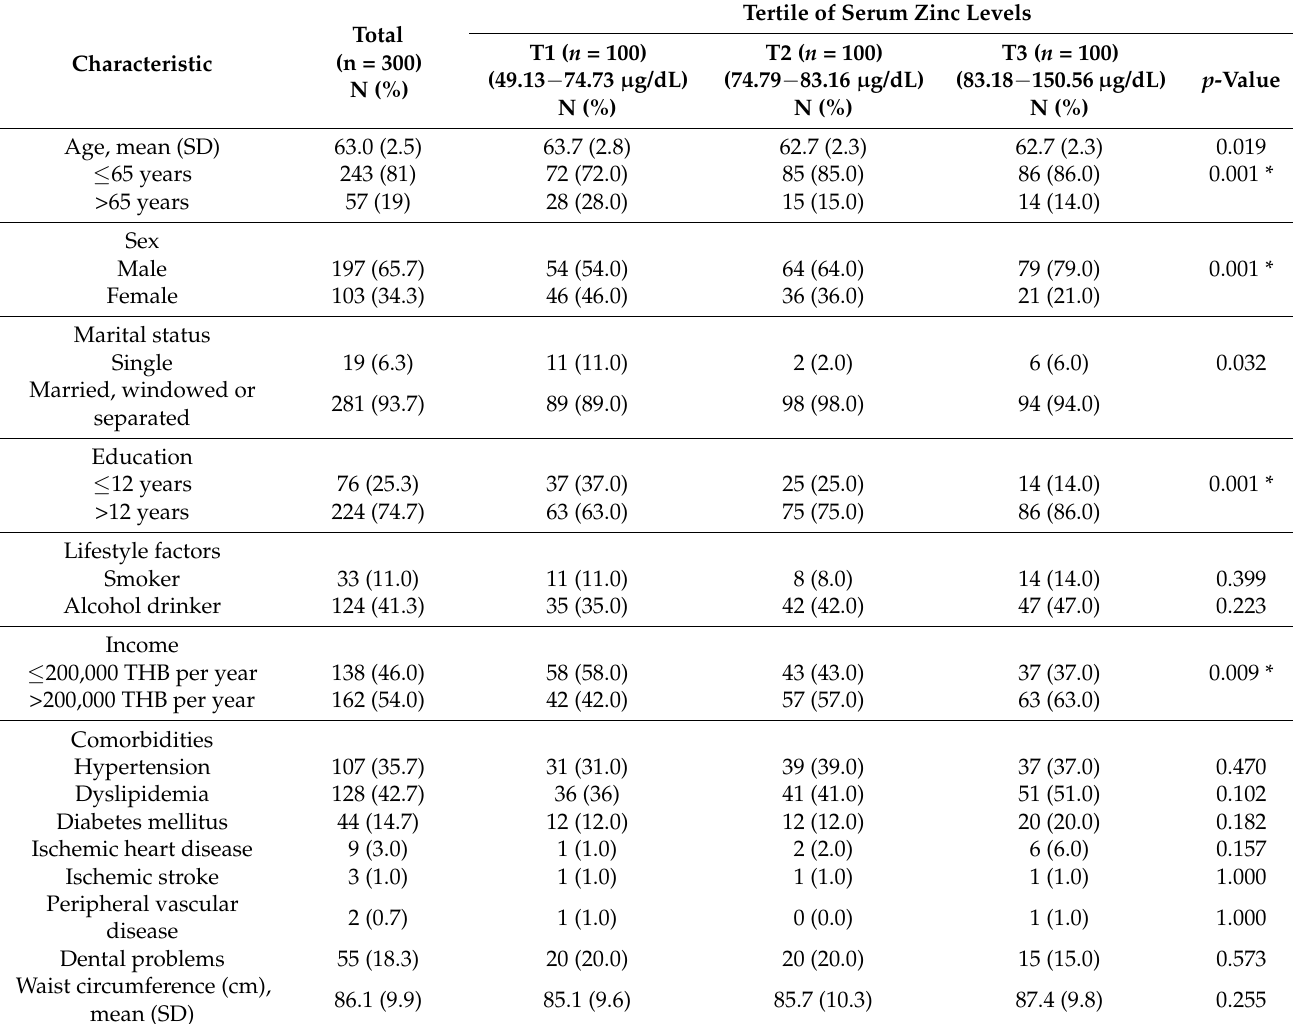
Table 1. Baseline and clinical characteristics of the participants classified by the tertile of serum zinc